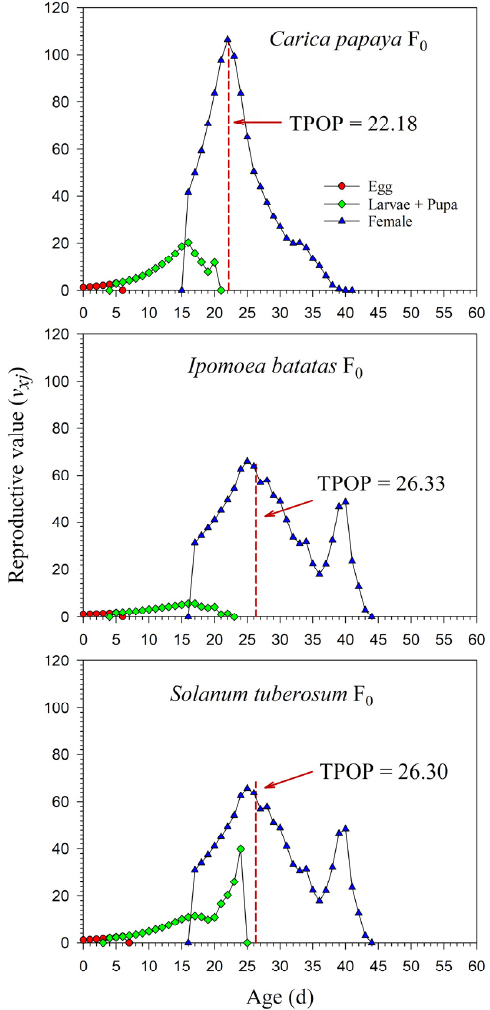
Figure 5. Age-stage-specific life expectancy ( e xj ) rates of Paracoccus marginatus individuals reared on four different host plants (F 0 ).